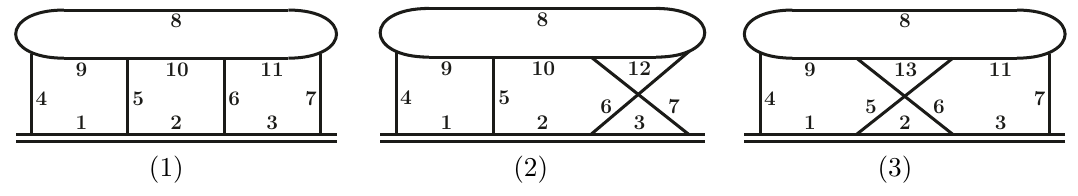
Figure 2 . Independent integral topologies (1,2,3) for the small angle expansion of V ( (cid:30) ). The number i for each (double) line refers to the corresponding propagator with power a i in G a according to eq. (2.14). Propagators 1,2,3 are (linear) Wilson line (heavy quark)